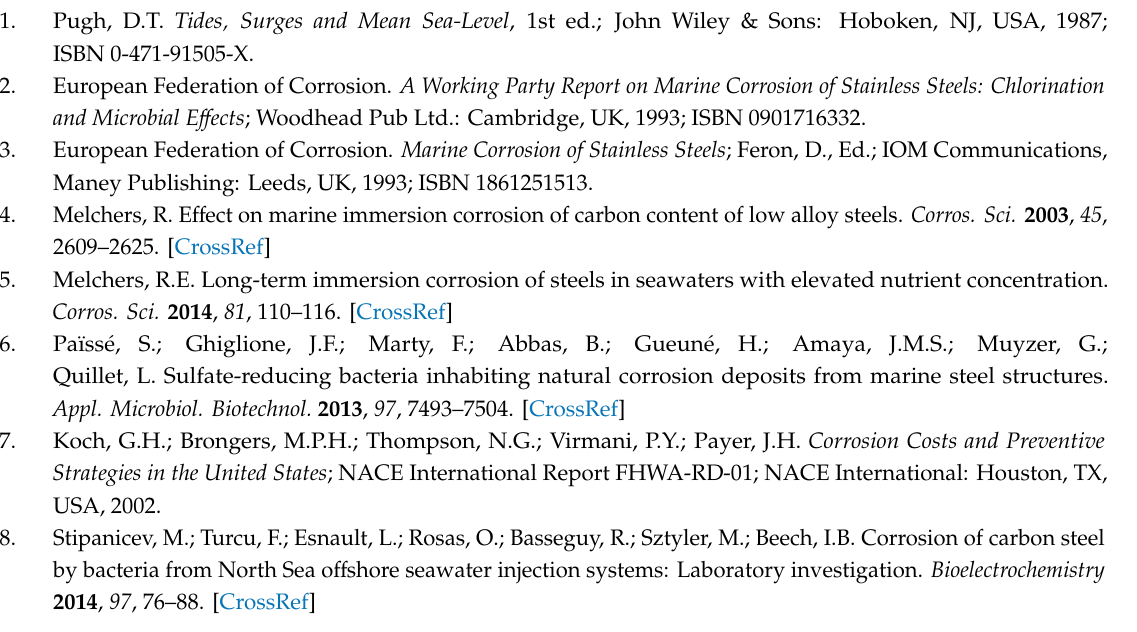
Table S1: sequence similarities of bacterial bands excised from DGGE, Figure S1: Visual analysis of the coupons after exposure to natural seawater. Representative images of visual inspection of the 316L stainless steel coupons that were under di ff erent conditions: (i) Reference, coupons not exposed to natural seawater. (ii) CFS, coupons continuously exposed to natural seawater for 5 and 15 weeks. (iii) STS, coupons exposed to simulated tidal conditions for 5 and 15